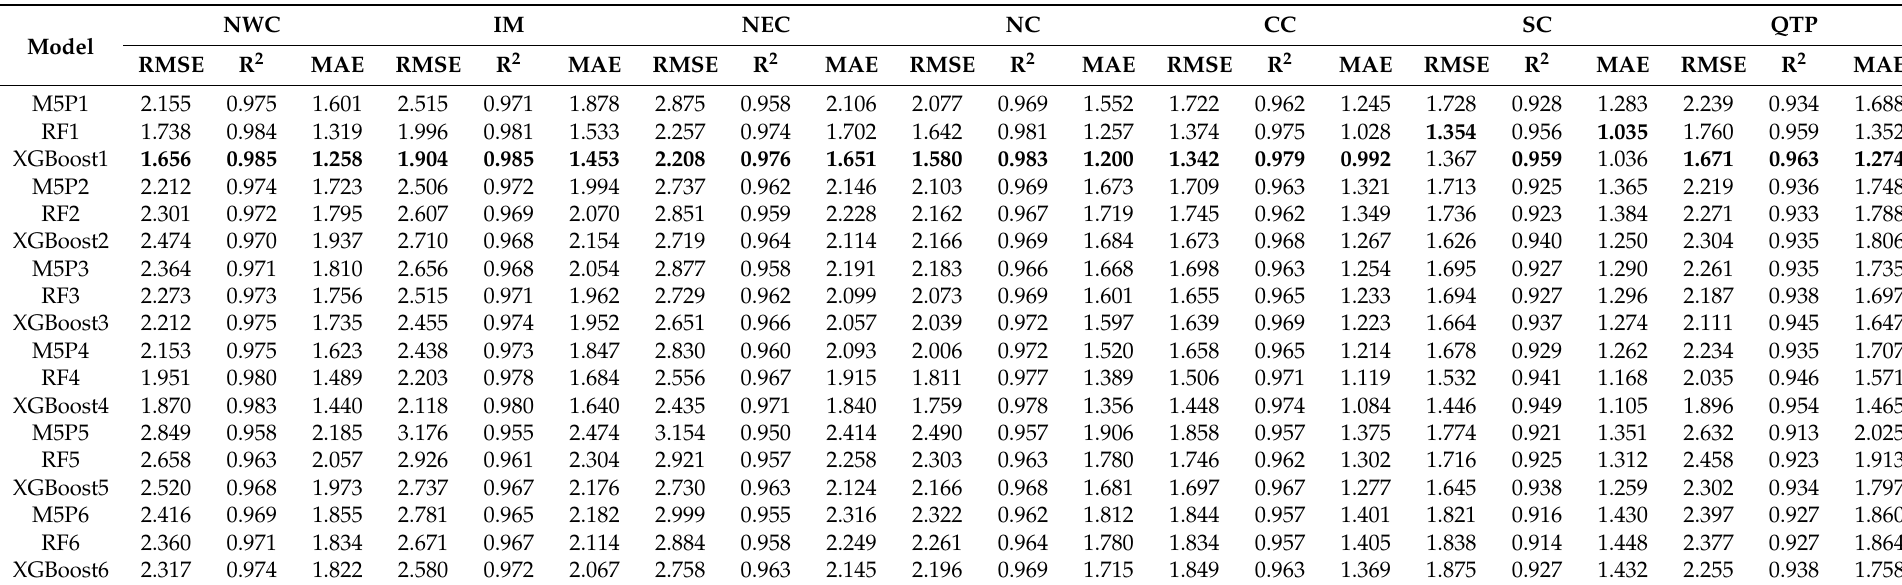
Table 3. Performance of data-driven models for the estimation of soil temperature in the different climatic zones of